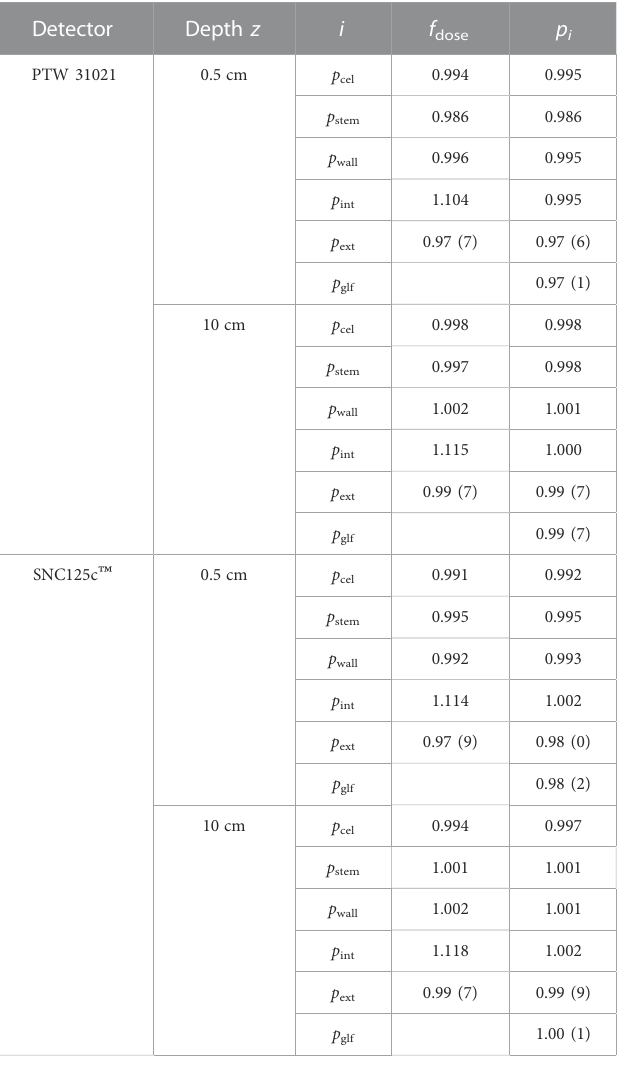
TABLE 2 Speci fi c fl uence correction factors p i for the perturbation caused by different constructive details from the PTW 31021 and SNC125c ™ as well as the calculated dose-conversion factor according to Eq. 9. The uncertainties vary below 0.1% for all unmarked values.